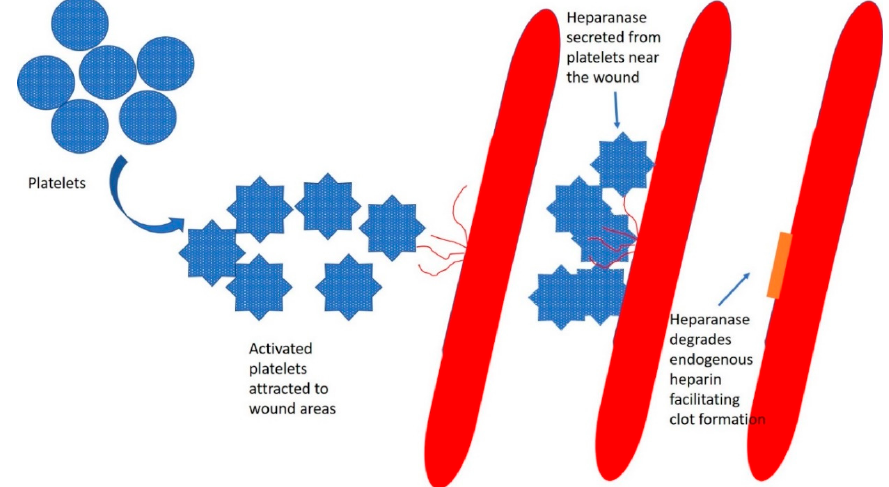
Figure 2. Platelets circulate in the blood. From left to right: Under normal conditions, the platelets are in their nonactive form in the circulation. When an endothelial injury occurs, blood leaks from the injured vessel, and the platelets are recruited to the wound area. The platelets degranulate its content. Heparanase secreted from the platelets degrades endogenous heparin in the blood interface within the wound area to facilitate clot formation. Heparanase also degrades heparan sulphate residues in the injured region as an initial step of wound